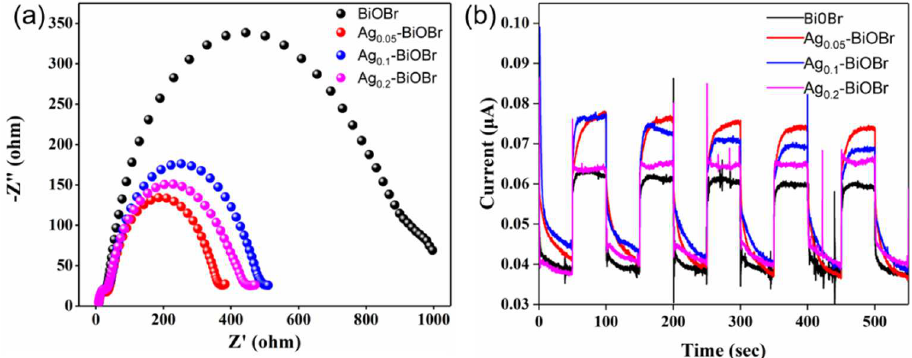
Figure 5. ( a ) EIS spectrum and ( b ) photocurrent response test plots of BiOBr and Ag-BiOBr .